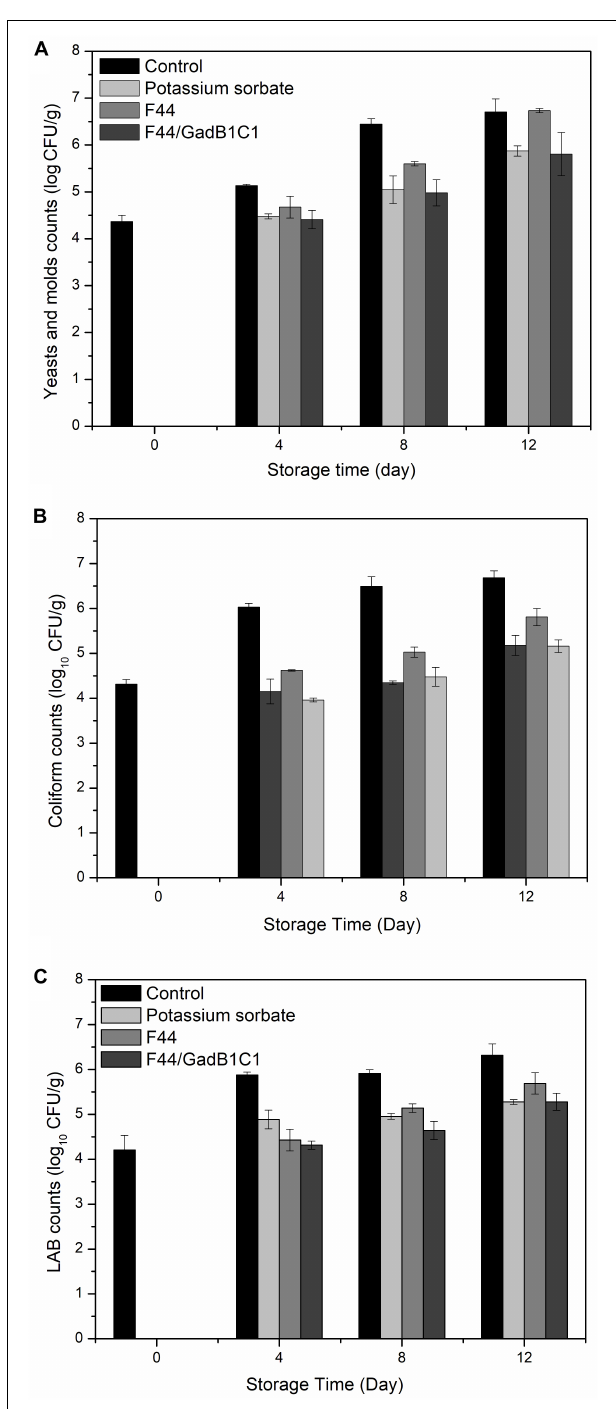
FIGURE 4 | Microbial changes in pork treated with potassium sorbate, F44 and F44/GadB1C1 fermentation product during storage at 4 ◦ C. (A) Yeasts and molds counts, (B) coliform counts, and (C) LAB